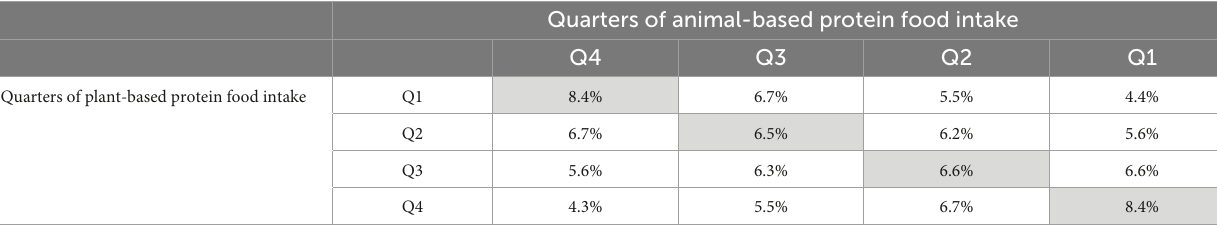
TABLE 3 Proportion of all participants in each quarter of animal- and plant-based protein food intake 1 , 2